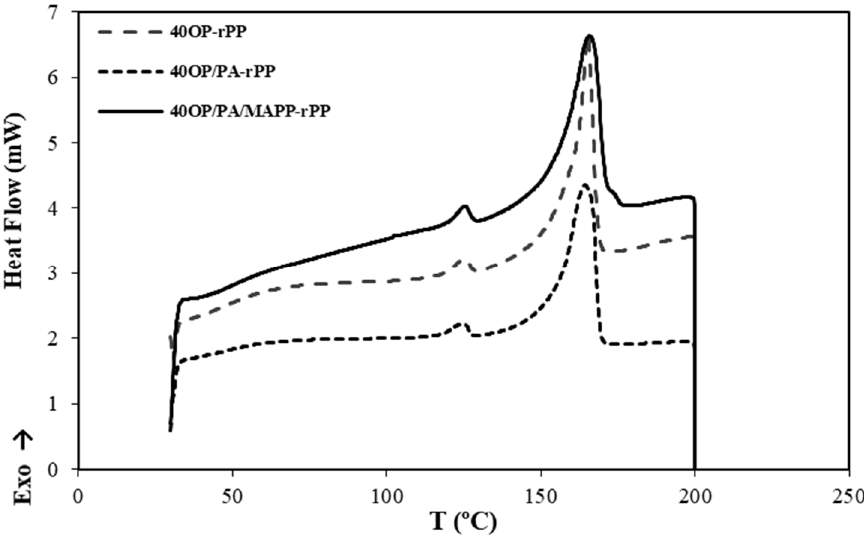
Figure 11. Thermograms resulting from the DSC performed on the composites reinforced with 40 wt% OP with and without additives.